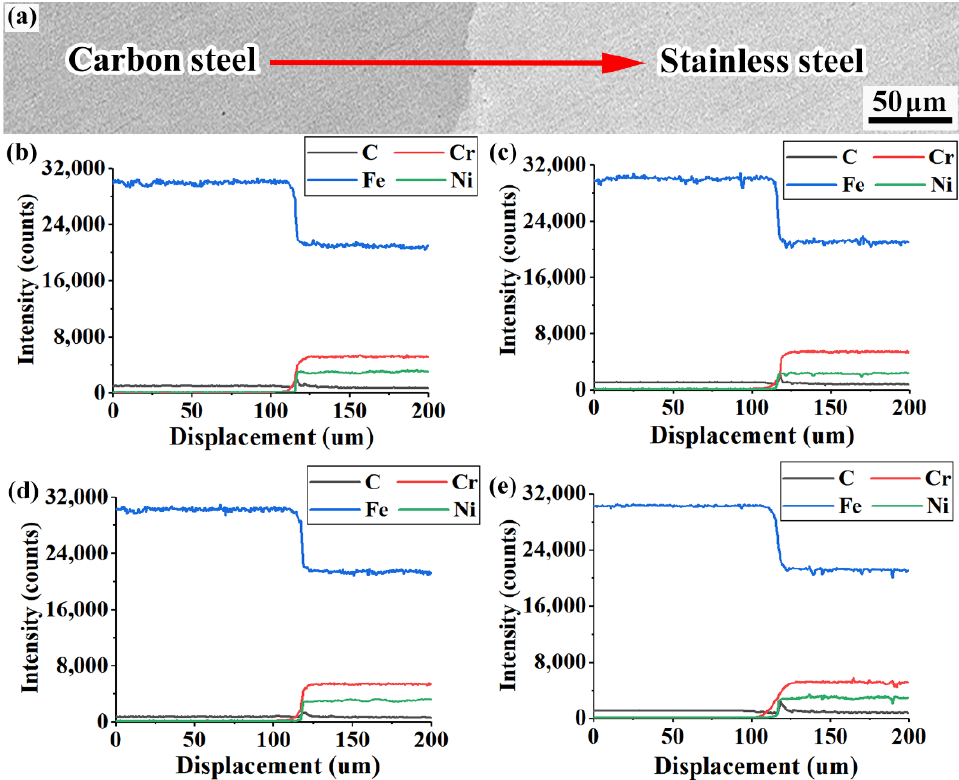
Figure 10. Results of EMPA analysis of various rebars: ( a ) EPMA line-sweep position; ( b ) 20MnSiV/316L rebar; ( c ) 35#/316L rebar; ( d ) 45#/316L rebar; ( e ) 55#/316L rebar.